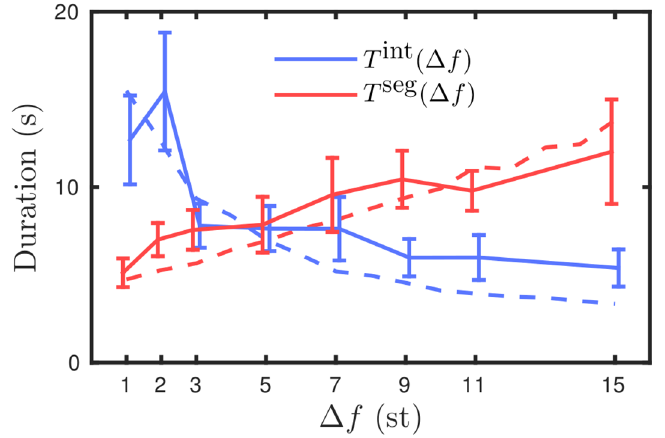
Fig 12. Non-normalized percept durations. Durations integrated and segregated without normalization plotted against Δ f for experiment and model with ( e dyn , i gbl ), as Fig